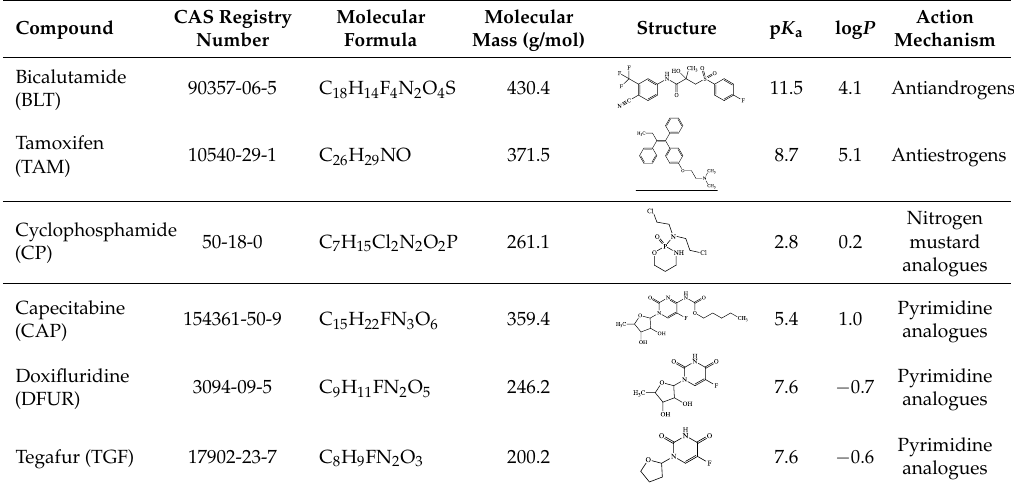
Table 3. Details of the target anticancer drugs typified by their action mechanisms (reconstructed based on the data listed in [41]).